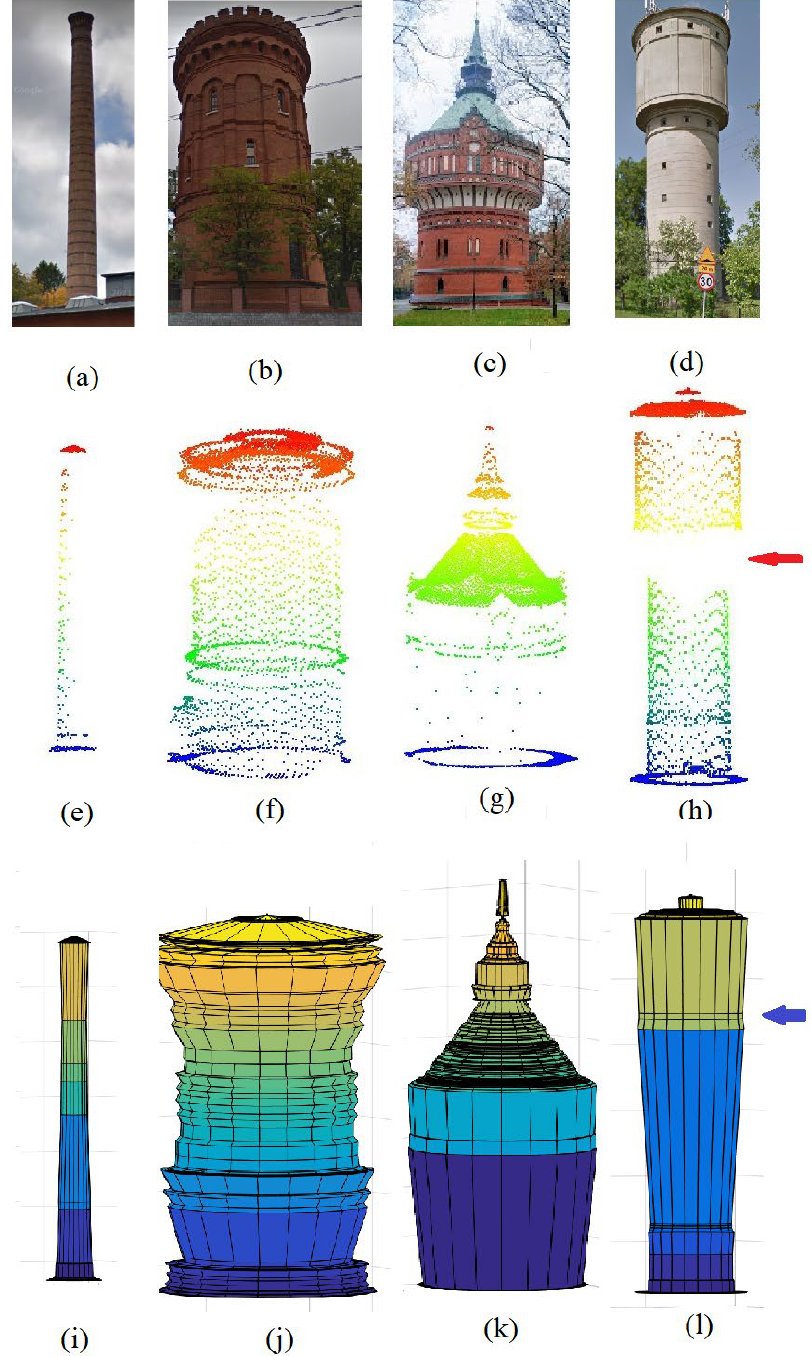
Figure 7. Modeling four tower point clouds; ( a – d ): tower images from Google Street View; ( e – h ): Tower point clouds; ( i – l ): 3D tower models.